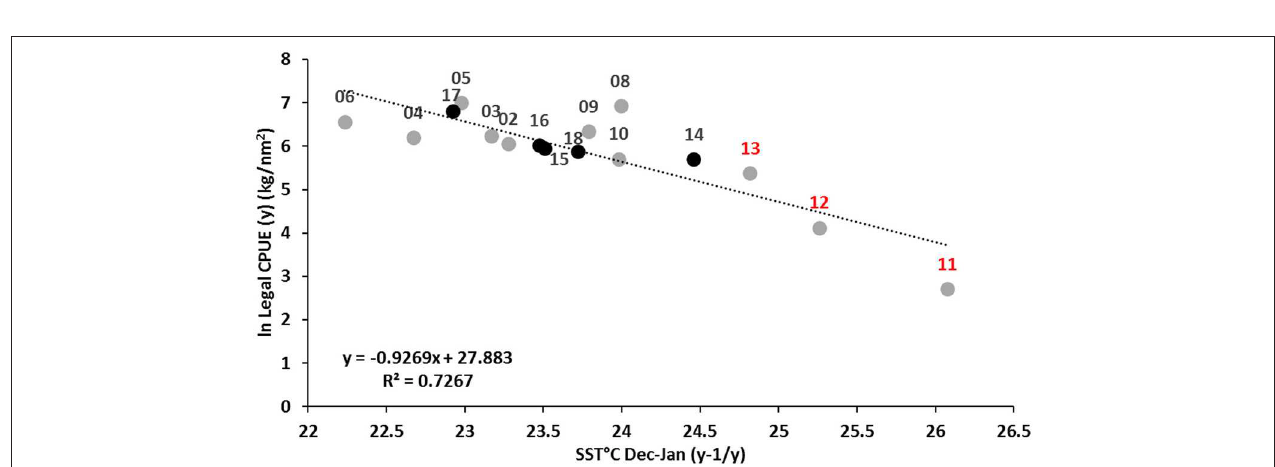
FIGURE 6 | Catch history of the Shark Bay Managed Fishery (by trap and trawl sectors) between 1989 and 2018. Also indicated is the total allowable commercial catch (TACC) levels from 2013/14 onwards when the fishery changed to a quota management system.